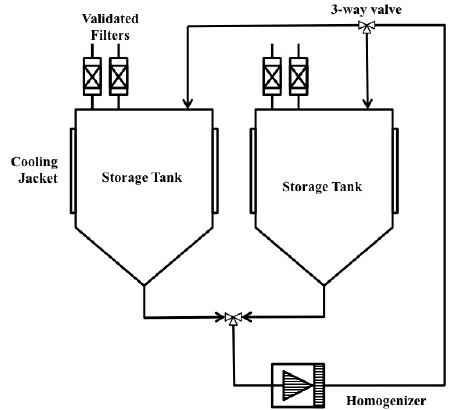
Figure 6. Example of a high pressure homogenizer system. Reproduced with permission from [18].